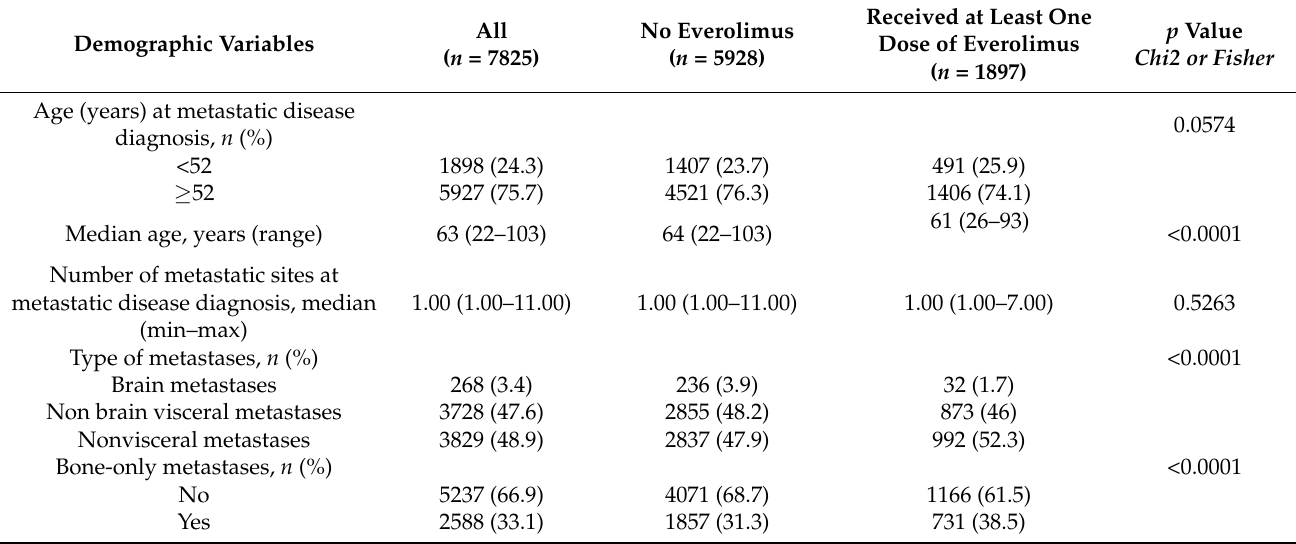
Table 1. Patient characteristics at onset of metastatic disease, according to everolimus